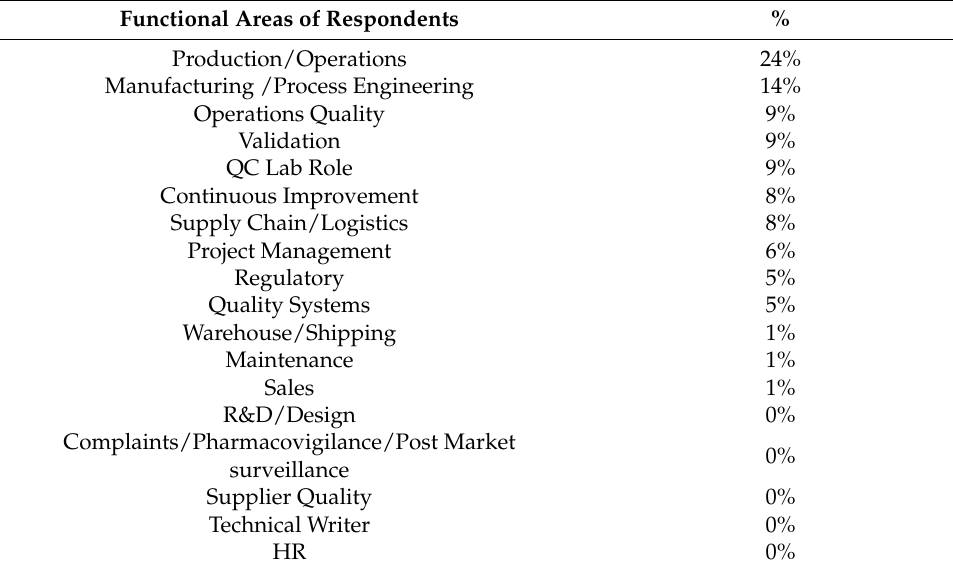
Table 1. Functional Areas within Pharma of the respondents.